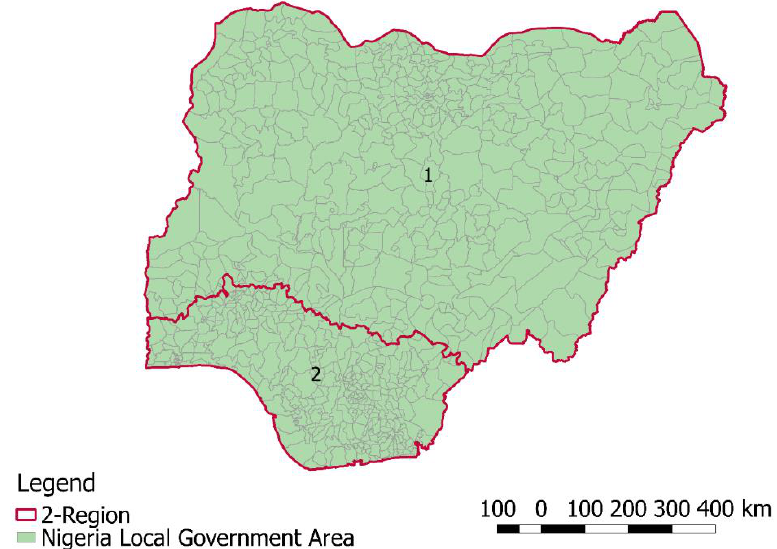
Figure 13. Bayesian change-point result: optimal number of regions using within-zone heterogeneity of soil health indicators.